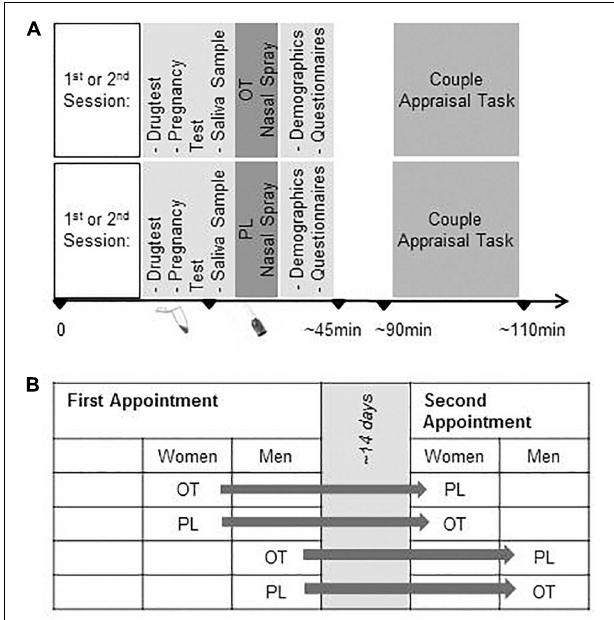
FIGURE 1 | (A) Experimental Procedure, and (B) Randomized Cross-Over Design. OT, oxytocin; PL, placebo.